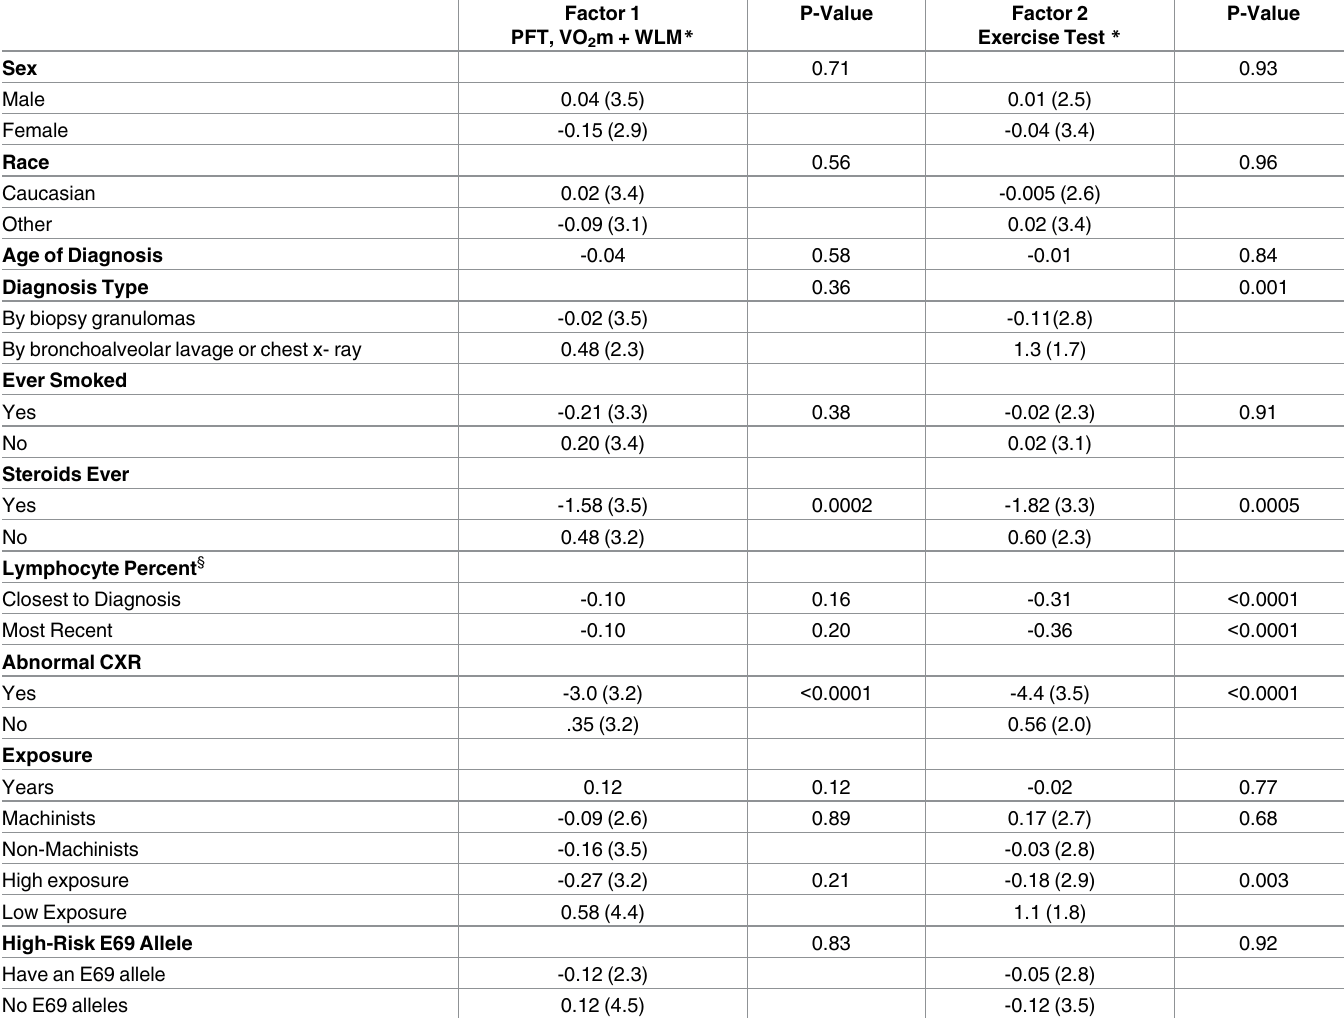
Table 3. Association between patient characteristics and factor composite